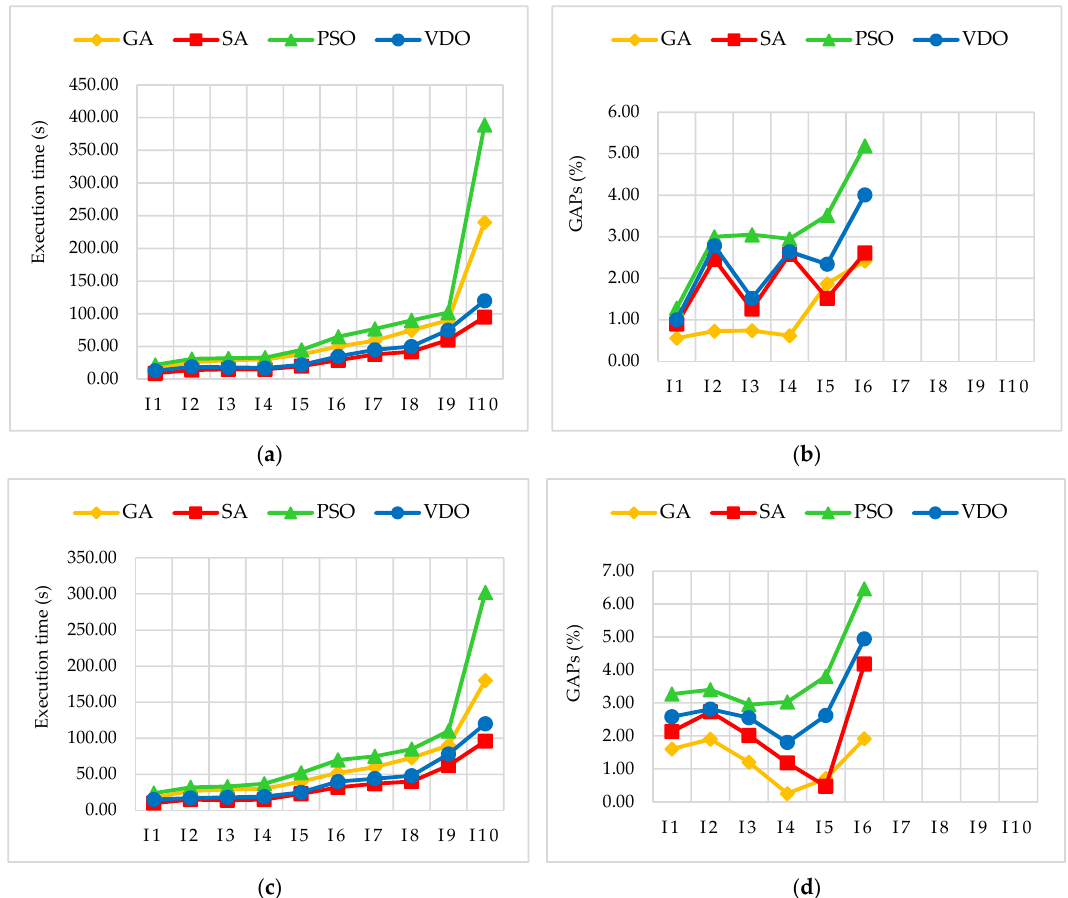
Figure 15. Comparison between the algorithms used in the different instances of the economic scenarios. ( a ) Execution time of Sc1_eco; ( b ) GAPs of Sc2_eco; ( c ) Execution time of Sc2_eco; ( d ) GAPs of Sc2_eco.